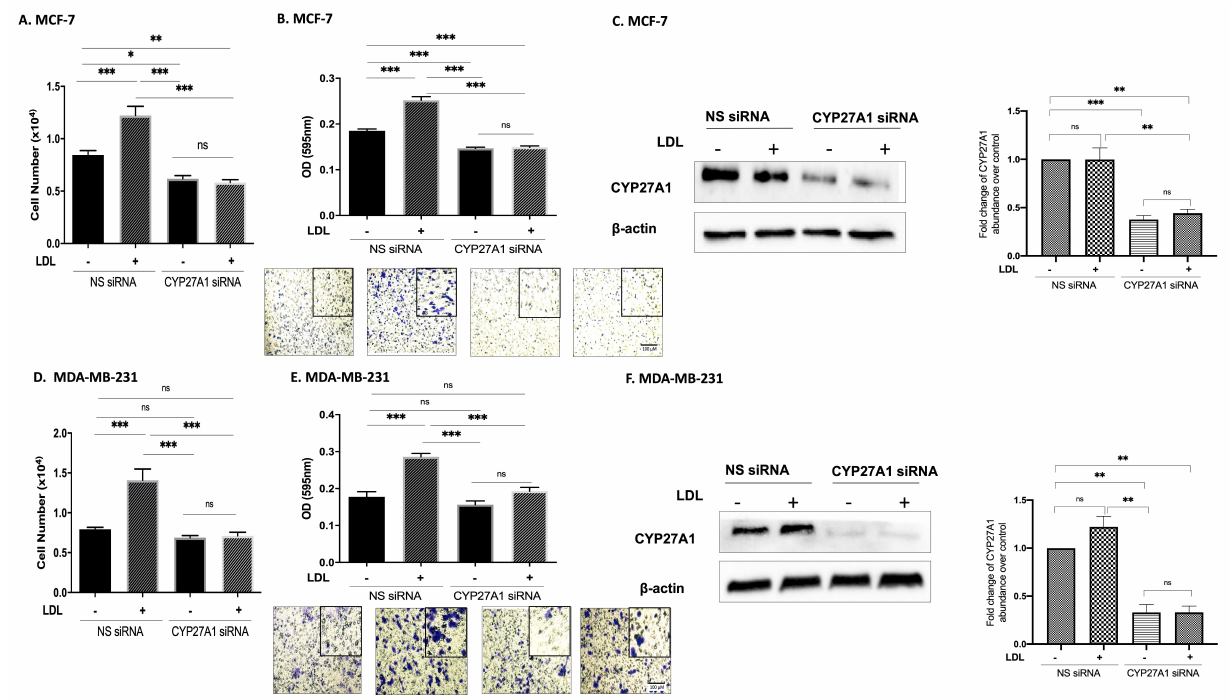
Figure 2. Cholesterol increases proliferation and migration through 27OHC production in breast cancer cells. Using the Muse cell analyser, we assessed the cell number for ( A ) MCF-7 and ( D ) MDA- MB-231 after being transfected with CYP27A1 siRNA and non-silencing RNA and being dosed with (LDL 80 µ g/mL) for 48 h. A trans-well assay was used to detect cell migration and invasion after being transfected with CYP27A1 siRNA and dosed with (LDL 80 µ g/mL). The migrated cells were stained with crystal violet, and images were taken ( × 20 magnification). The migrated cells were quantified for ( B ) MCF-7 after 24 h and ( E ) MDA-MB-231 after 6 h of incubation time. Western immunoblot analysis was performed to show the protein abundance of CYP27A1 MCF ( C ) for MCF-7 and ( F ) MDA-MB-231 with or without LDL and CYP27A1 silencing. Additionally, the relative fold changes of CYP27A1 against loading control β -actin were measured ( C , F ). p -values were determined by using the one-way statistical analysis of GraphPad Prism: ANOVA test plus least significant difference (LSD) post-hoc test (* p < 0.05, ** p <0.01, *** p <0.001). Scale bar represents 100 µ